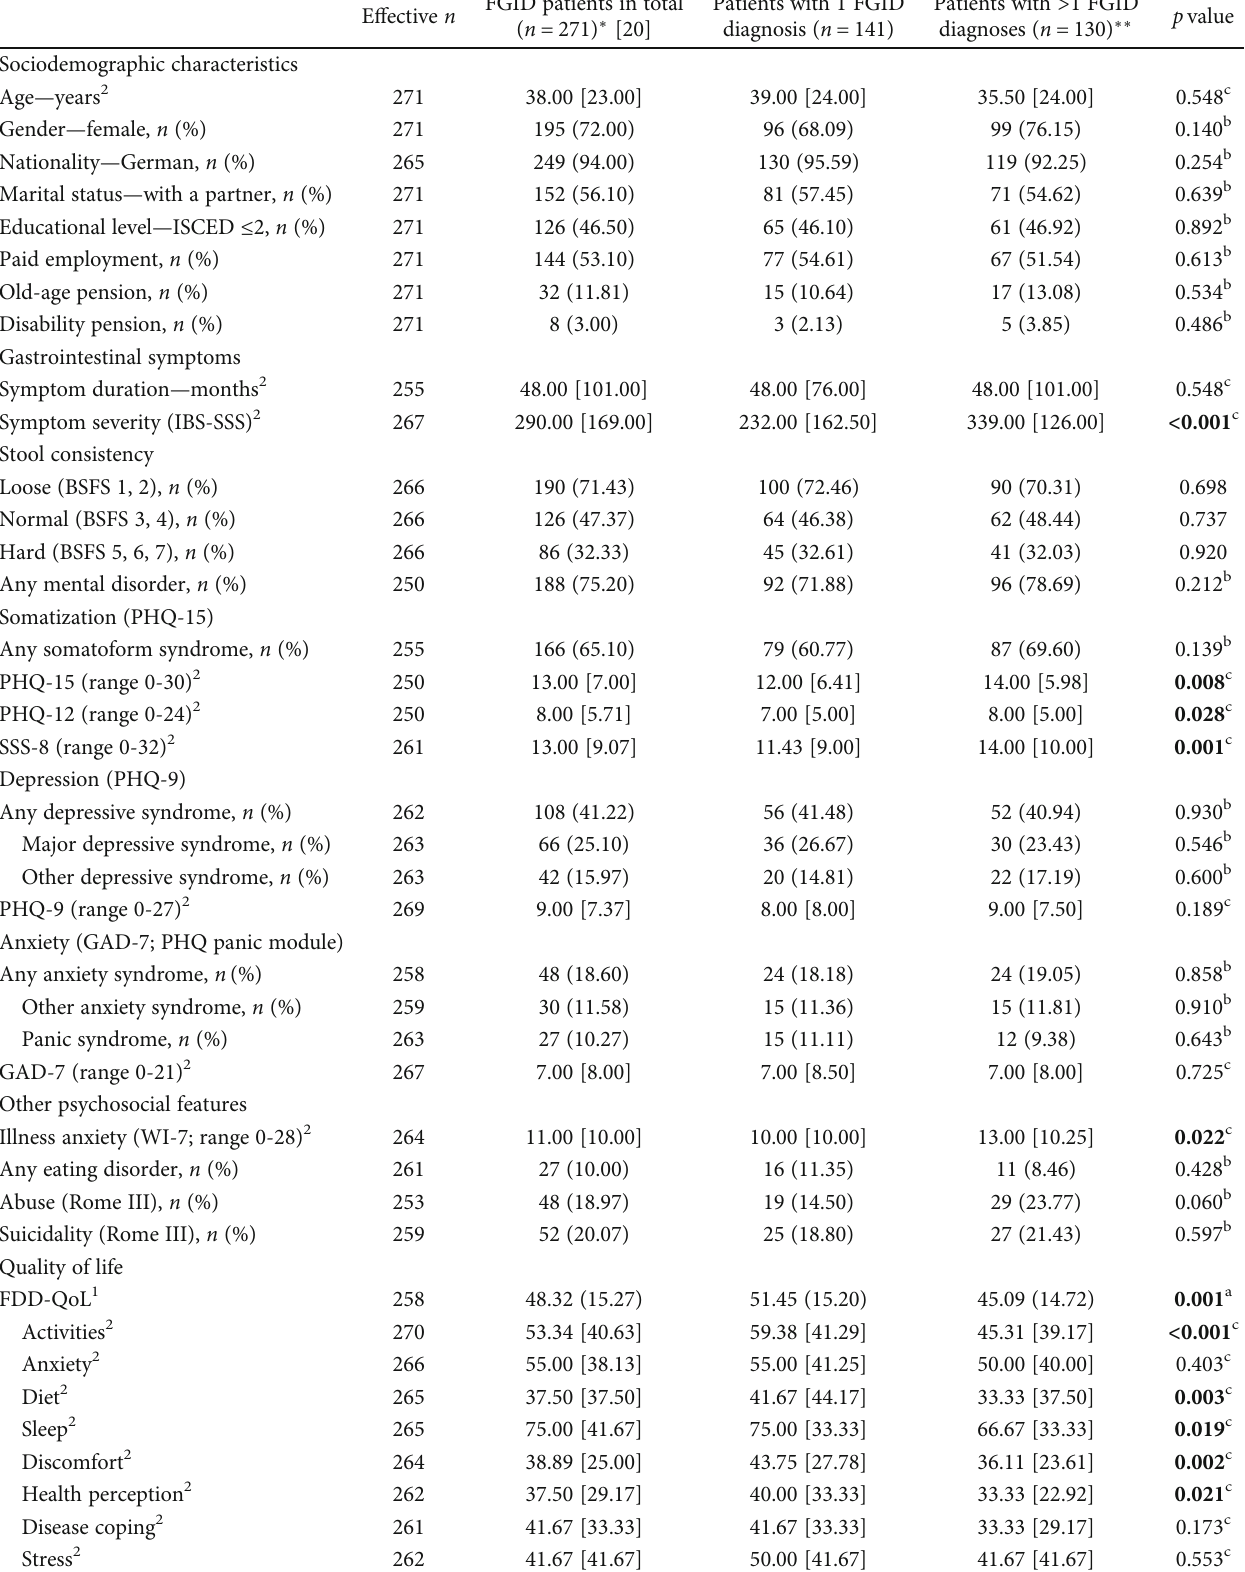
Table 2: Sociodemographic, physical, and psychosocial features of FGID